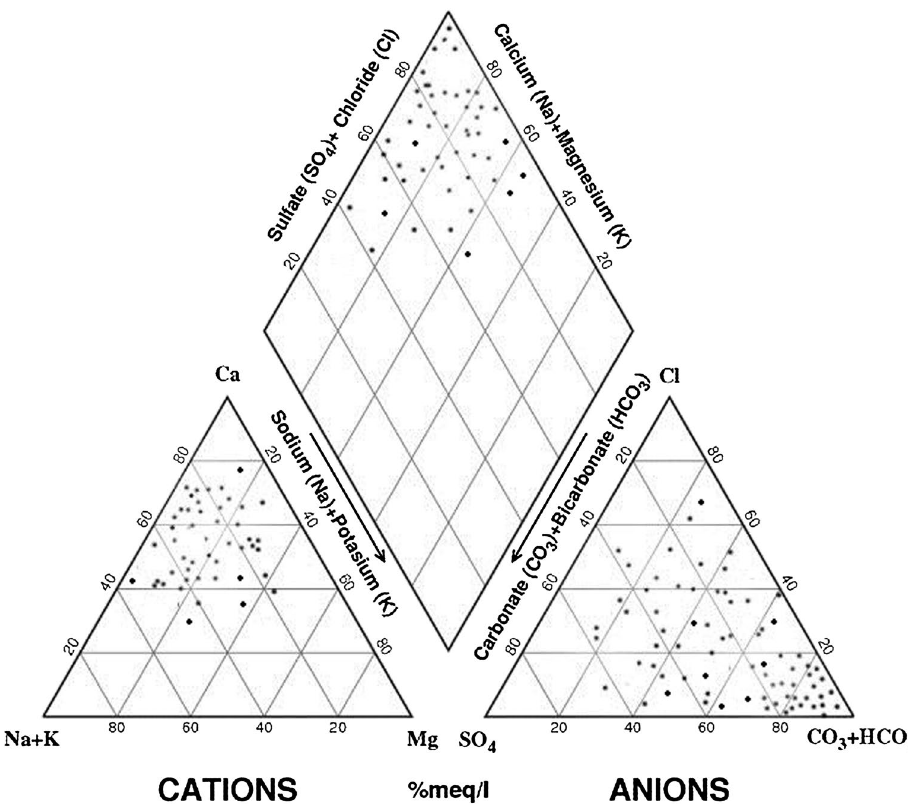
Fig. 14 Piper trilinear plotting representative the hydro-geo- chemical evolution of